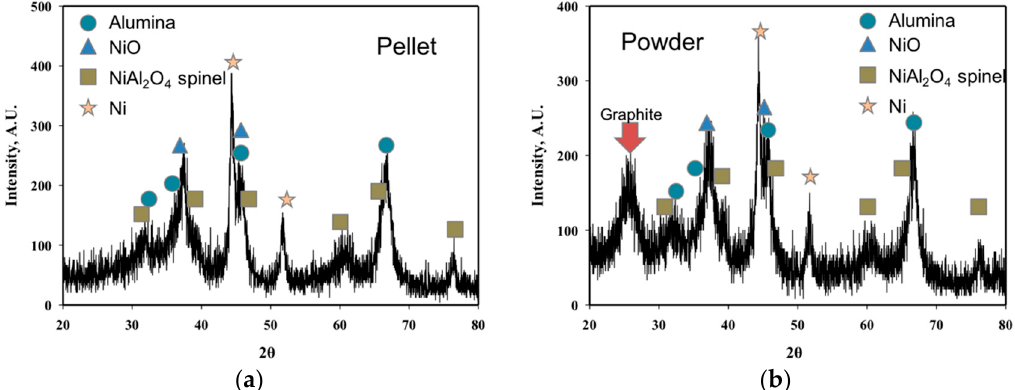
Figure 3. Image of pellet-shaped catalyst collected after ( a ) steam reforming at 800 °C, S/C = 3.0, and O 2 /C = 0.2; and ( b ) auto-thermal reforming at 800 °C, S/C = 3.0, and O 2 /C = 0.2. Figure 4. X-ray diffraction (XRD) patterns of ( a ) catalyst pellet and ( b ) associated powder obtained after toluene steam reforming at 800 °C, S/C = 3.0, and O 2 /C = 0.2.